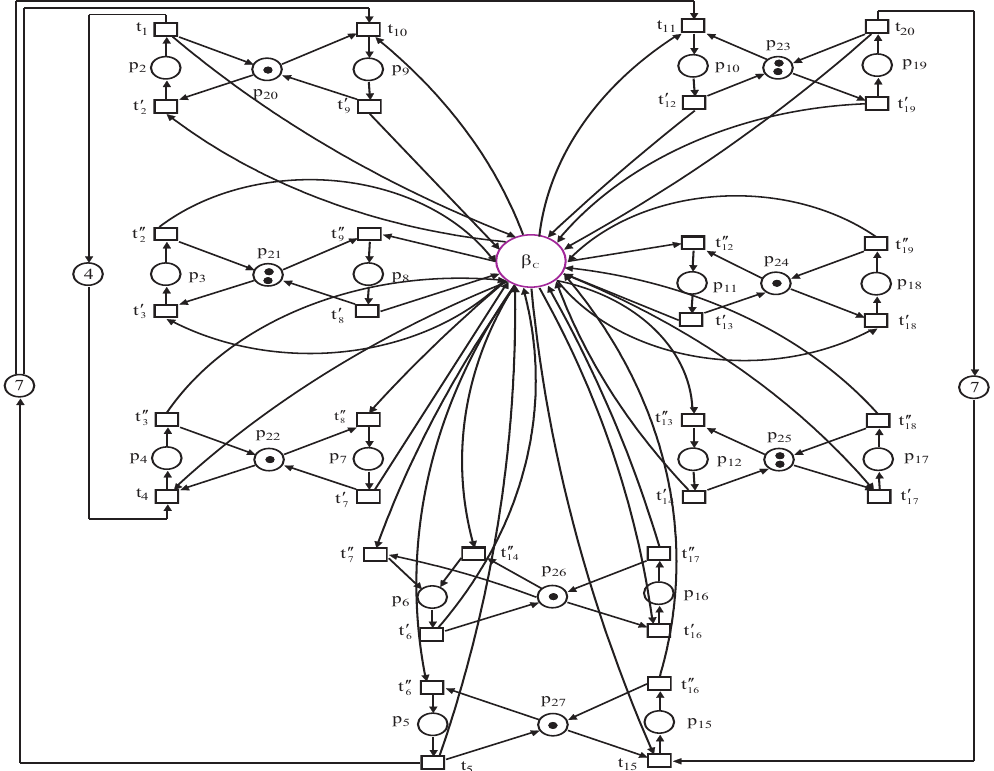
) model using a global 0